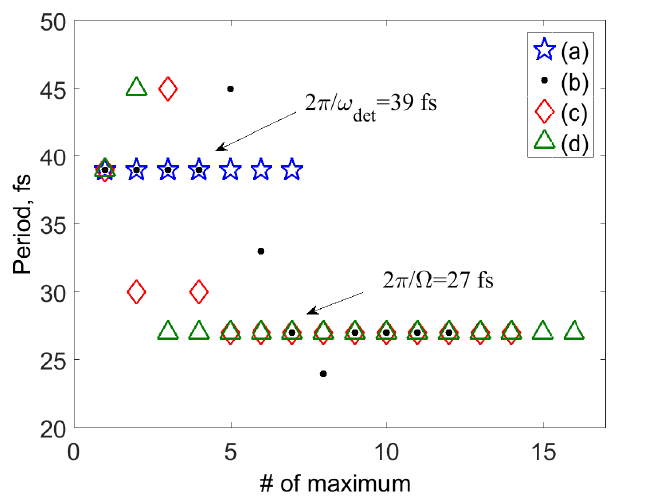
− τ max n between the adjacent local maxima S n + 1